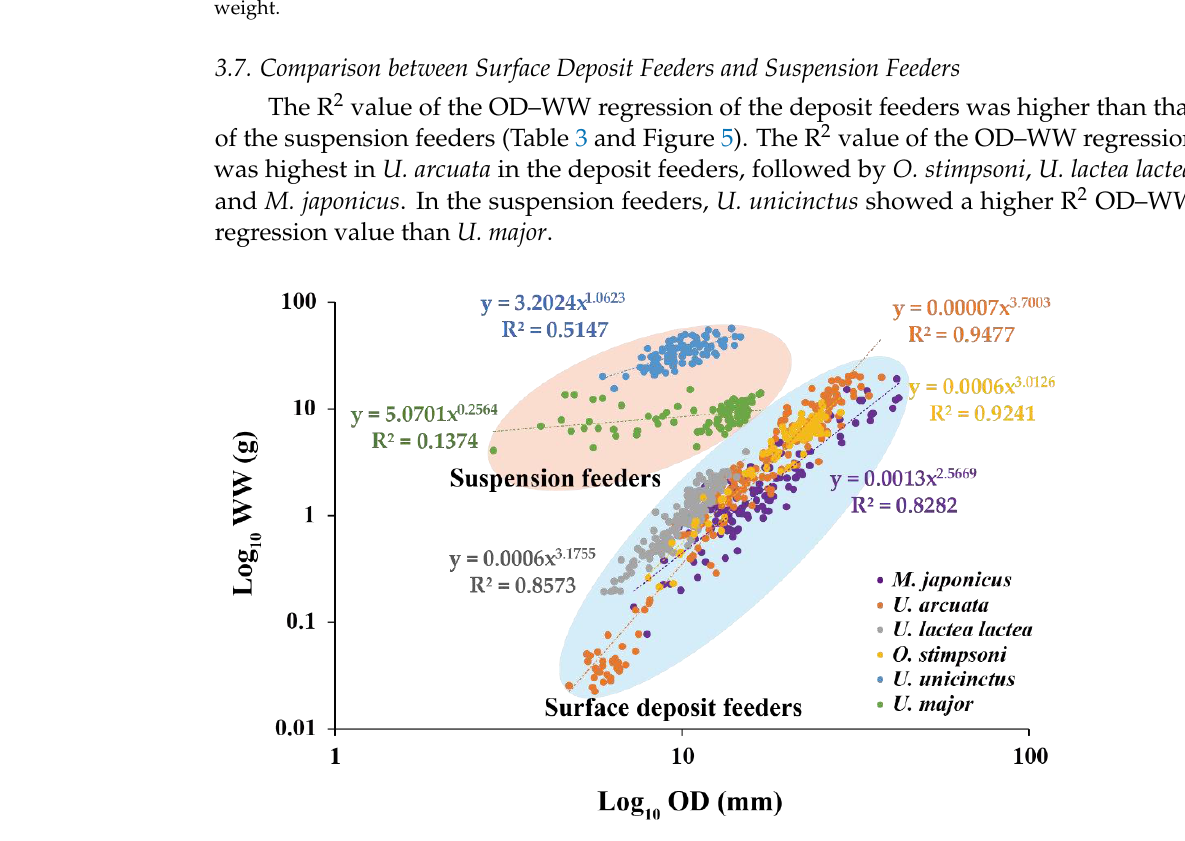
Table 4. Comparison of morphometric data (mean value ± standard deviation) and regression coef- ficient (R 2 ) between normal and abnormal openings for U. major (* p < 0.05, ** p < 0.01, *** p < 0.001). Significant differences by t -test at 0.05.